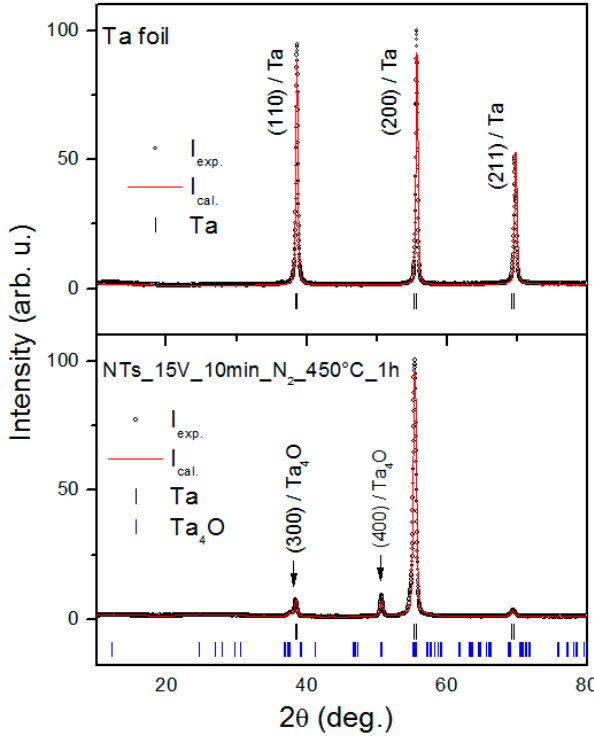
Figure 3. X-ray diffraction patterns for the Management Information Base (MIB) sample before (top) and after (bottom) the anodization process. Open circles represent experimental data, whereas the solid red line is a LeBail profile fit with two models used: Ta (Im-3m) and Ta 4 O (Pmmm) shown by black and blue vertical bars, respectively.